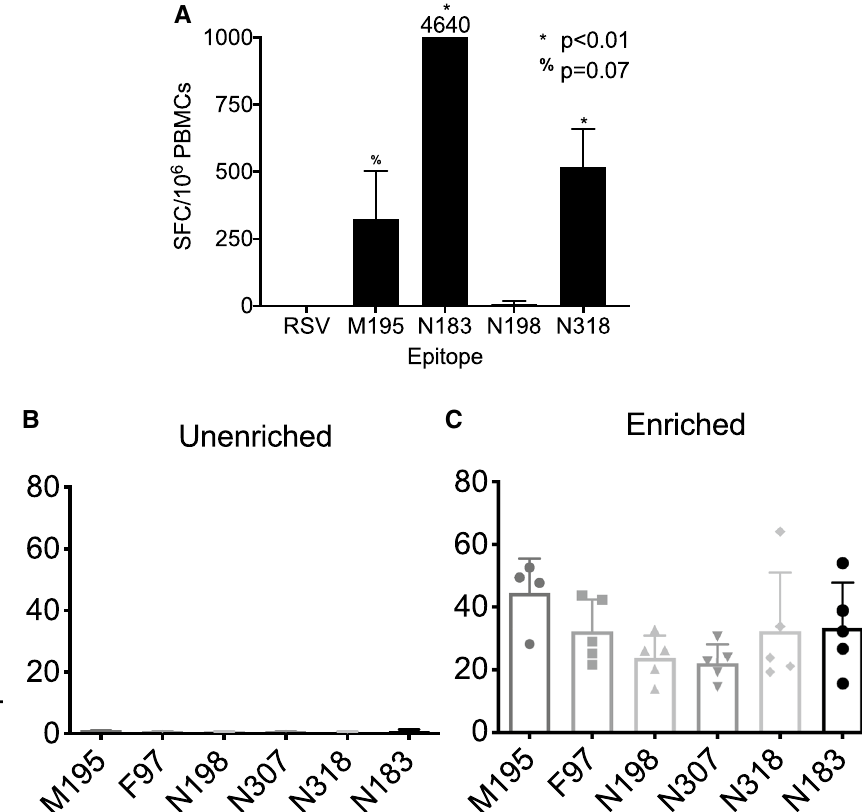
Figure 5. Human HLA-B*07:02 PBMCs recognize HMPV peptides. ( A ) Human HLA-B*07:02 PBMCs from a single donor were incubated with 10 μM HMPV peptides and recombinant human IL-2 for 7 days, IFNγ ELISPOT performed as described, and SFC expressed as average SFC/10 6 human PBMC in triplicate wells corrected by subtracting SFC from irrelevant peptide control wells. ( B ) Human HLA-B*07:02 PBMCs from 5 distinct donors were incubated with APC-labeled HMPV tetramers, enriched through a magnetic column with anti-APC beads and both depleted flowthrough unenriched (left) and enriched (right) fractions analyzed via flow